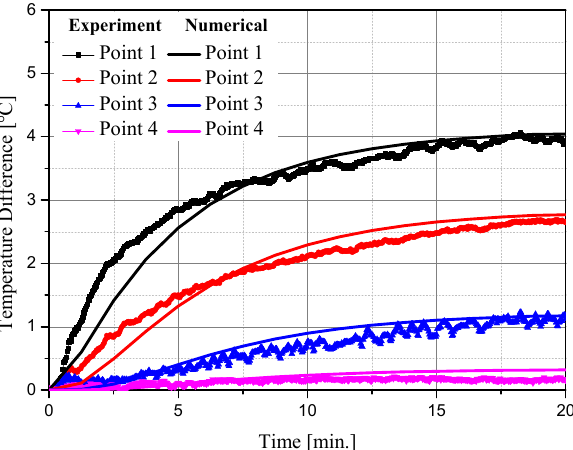
Figure 4. Comparison of temperature measurement results of the experiment and numerical analysis.